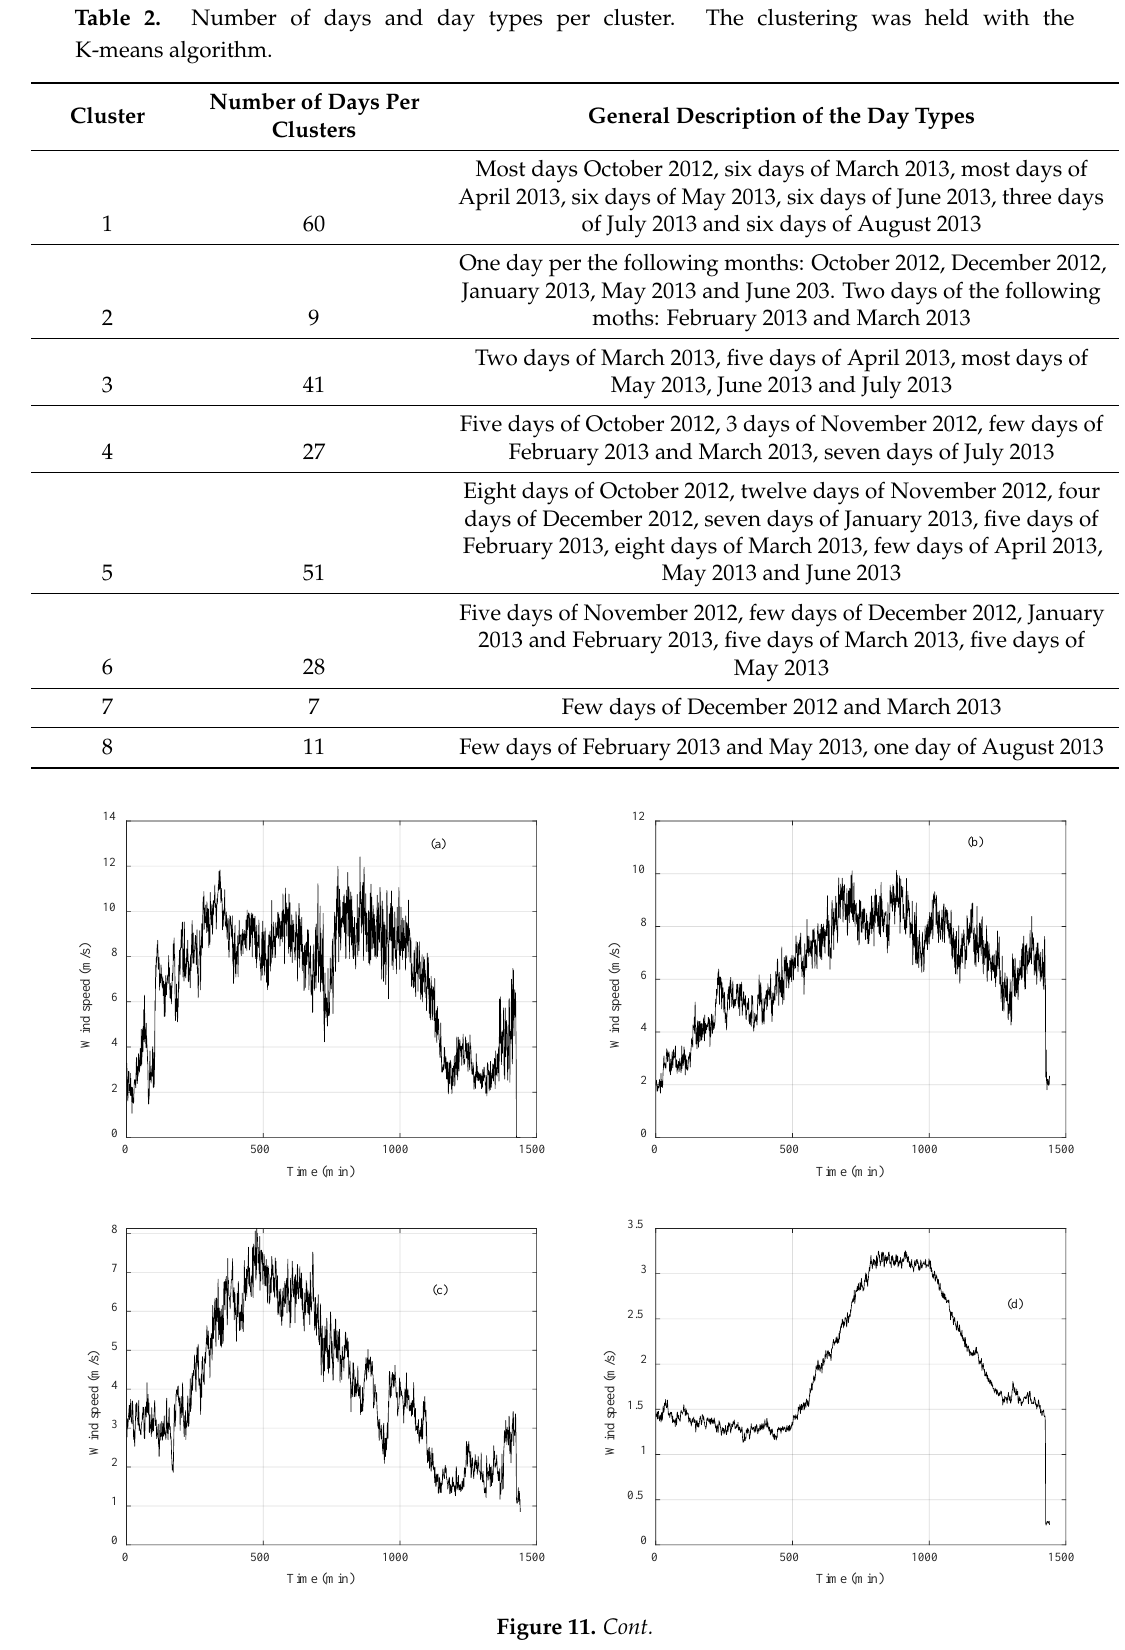
Table 2. Number of days and day types per cluster. The clustering was held with the K-means algorithm.